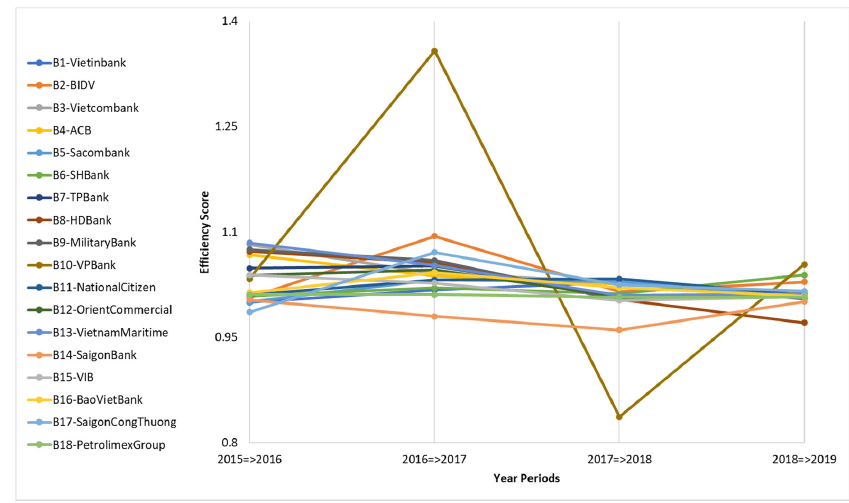
Figure 3. The technological change indexes of the DMUs.